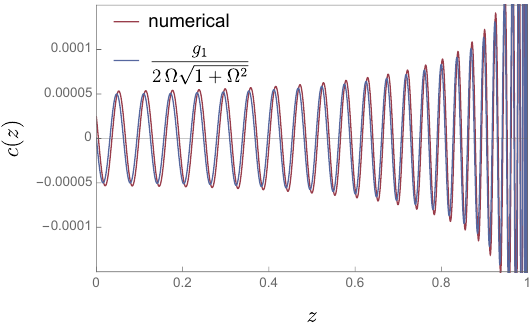
Figure 15 . Comparison of the critical solution for c obtained by numerically solving the non-linear full equation of motion and (C.42) for (cid:10) = 100, m = 1 and (cid:15) = 1